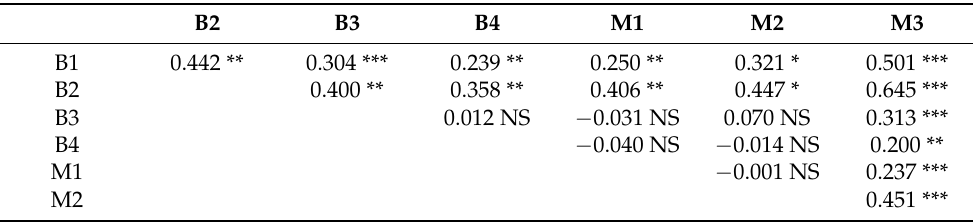
Table 5. Genetic differentiation estimated by R ST pairwise comparisons of regional collections of X. euvesicatoria strains from Bulgaria (B1-B4) and North Macedonia (M1-M3) based on the VNTR- rep dataset. B2 B3 B4 M1 M2 M3 B1 0.442